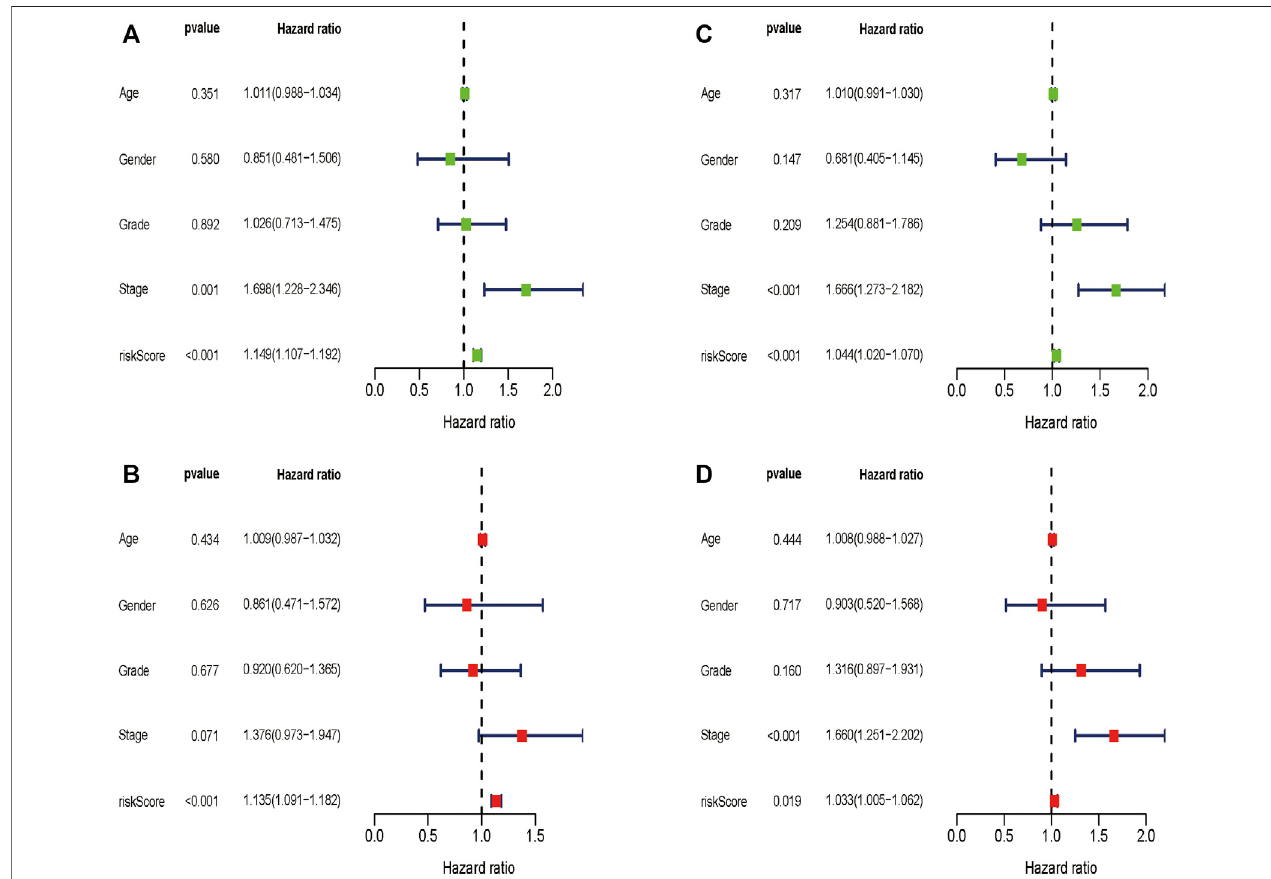
FIGURE7| Univariateandmultivariate Coxregressionanalysesinthetwocohorts.MultivariateCoxregressionanalysesinthetrainingcohort (A) andthevalidation cohort (C) . Univariate Cox regression analyses in the training cohort (B) and the validation cohort (D) .